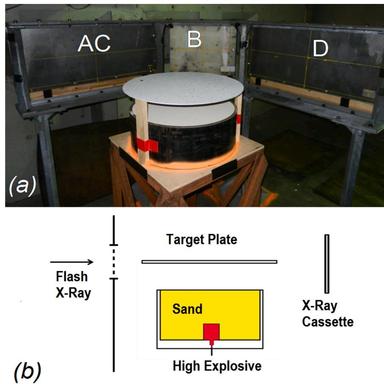
The axisymmetric buried charge setup: general view inside the test chamber (a) and schematic side view of the test arena (b).